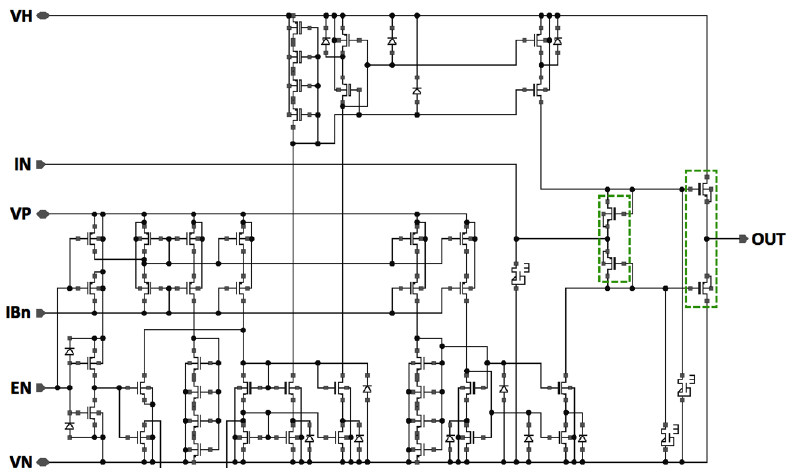
Figure 3. Complete schematic of the source follower.